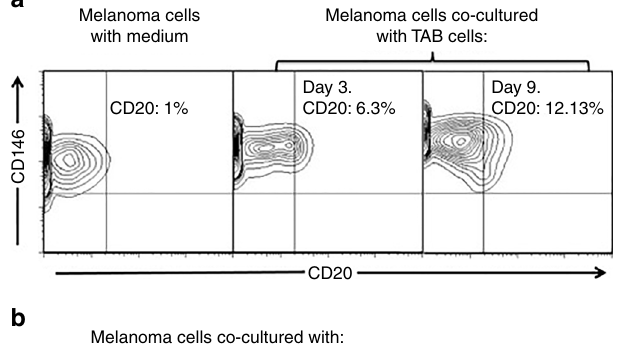
Fig. 4 IGF-1-dependent induction of cancer stem cell markers CD20, CD133, and CD271 (NGFR) on melanoma cells. a Melanoma cells (WM3749) co- cultured with TAB cells (days 3 and 9) show high expression of CD20 ( middle and right panels ) compared with the control culture ( left panel ) as determined by FACS analysis. Melanoma cells were co-stained with anti-CD146 (MCAM, PE-conjugated) and anti-CD20 (FITC-conjugated) antibodies to distinguish them from B cells, which are CD146-negative;percentages indicate co- expression of both markers on the malignant cells. b Melanoma cells (WM3749) co-cultured with TAB cells (day 6) show high expression of CD20, CD133 and CD271 ( left panel ) compared with minimal or low expression of those markers when tumor cells are co-cultured with NB cells ( right panel ). Co-culture of melanoma cells with TAB cells did not modulate the expression of CD144 (vascular-endothelial cadherin marker) that are normally expressed by aggressive melanomas (data not shown). Induction of CD20, CD133, and CD271 was blocked when anti-IGF-1 neutralizing antibody (10 μ g/ml) was used in the co-culture ( middle panel ). Anti-IL-1, anti-PDGF or anti-VEGF antibodies had no effect on CD marker expression (data not shown). Percentages indicate co-expression of CD20, CD133, or CD271on CD146 + melanoma cells. Results are representative of two independent experiments. c Melanoma cells(WM3749, WM989 and 451Lu) cultured in the presence of recombinant IGF-1 (25ng/ml) for 5 days showed high expression of CD20 or CD271 ( red bars ) compared with untreated cells ( blue bars ) as determined by FACS assay. Bar represents mean+SE of triplicate samples